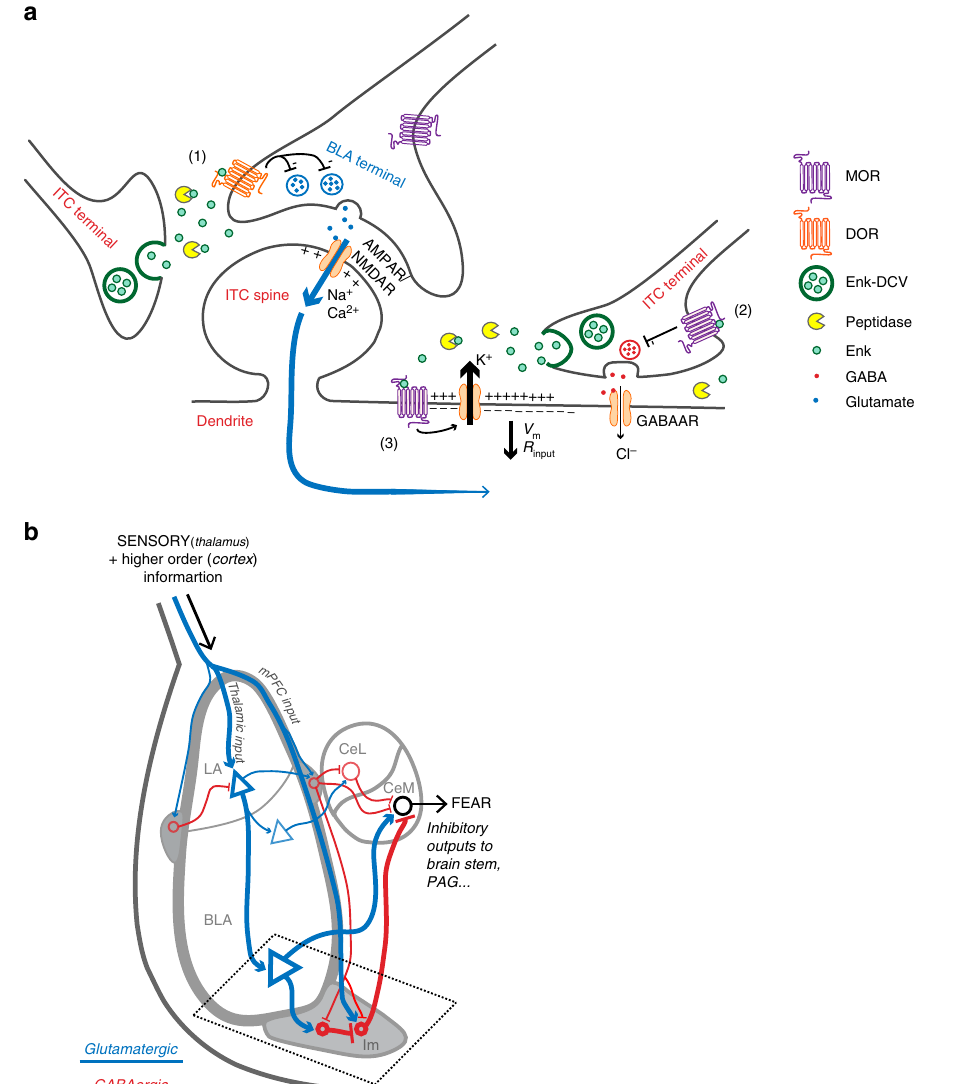
Figure 7 | Working model of endogenous opioid actions in Im. ( a ) Working model of endogenously released opioid signalling within Im. (1) Low–moderate stimuli at BLA-Im synapses promote release of endogenous enkephalins from dense core vesicles (DCV) contained within Im neurons. Sufficient peptide release through moderate stimulation is required to overcome peptidases and allow enkephalin signalling through DOR. Enkephalin reduces BLA-Im synaptic activity by decreasing pre-synaptic glutamate release. (2) Moderate stimuli, together with peptidase inhibition, are required to overcome potential microarchitectural constraints to allow enkephalin-induced MOR activation that reduces presynaptic GABA release at local Im–Im synapses. (3) Activation of postsynaptic MORs by endogenously released opioids activates a potassium conductance. The resulting efflux of K þ ions hyperpolarizes ITCs reducing their excitability. Subsequent synaptic activity is also shunted (for example, blue arrows) due to decreased input resistance. Both outcomes are expected to reduce total Im activity and limit feed forward inhibition from Im to CeM neurons, thus affecting amygdala output. ( b ) Schematic representation of information flow through the amygdala. Putative thalamic/cortical glutamatergic (blue) afferents carry sensory information to the lateral amygdala (LA), activating BLA pyramidal neurons. These subsequently activate medial central amygdala (CeM) output neurons to promote fear behaviour. BLA excitatory afferents also project to Im, which then sends inhibitory GABAergic (red) efferents to the CeM. Other inputs (for example, from mPFC), traverse the intermediate capsule to activate Im neurons and contribute to feed-forward inhibition of CeM, preventing a fear response. Thinner lines depict putative inputs from the cortex, lateral/medial ITCs and the lateral central amygdala (CeL), all of which directly or indirectly affect amygdala